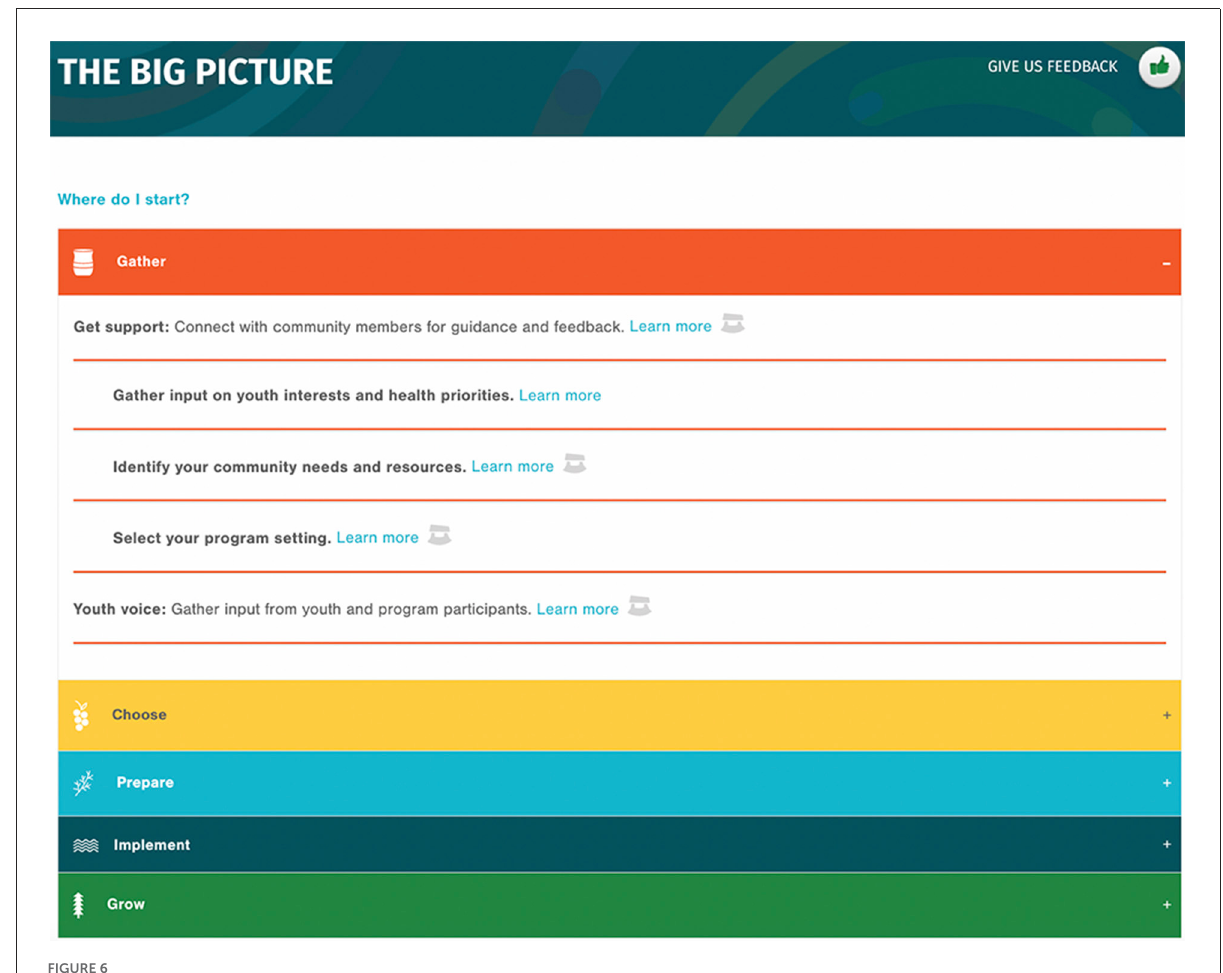
FIGURE6 Screen capture of the Healthy Native Youth Implementation Toolbox : The Big Picture feature.